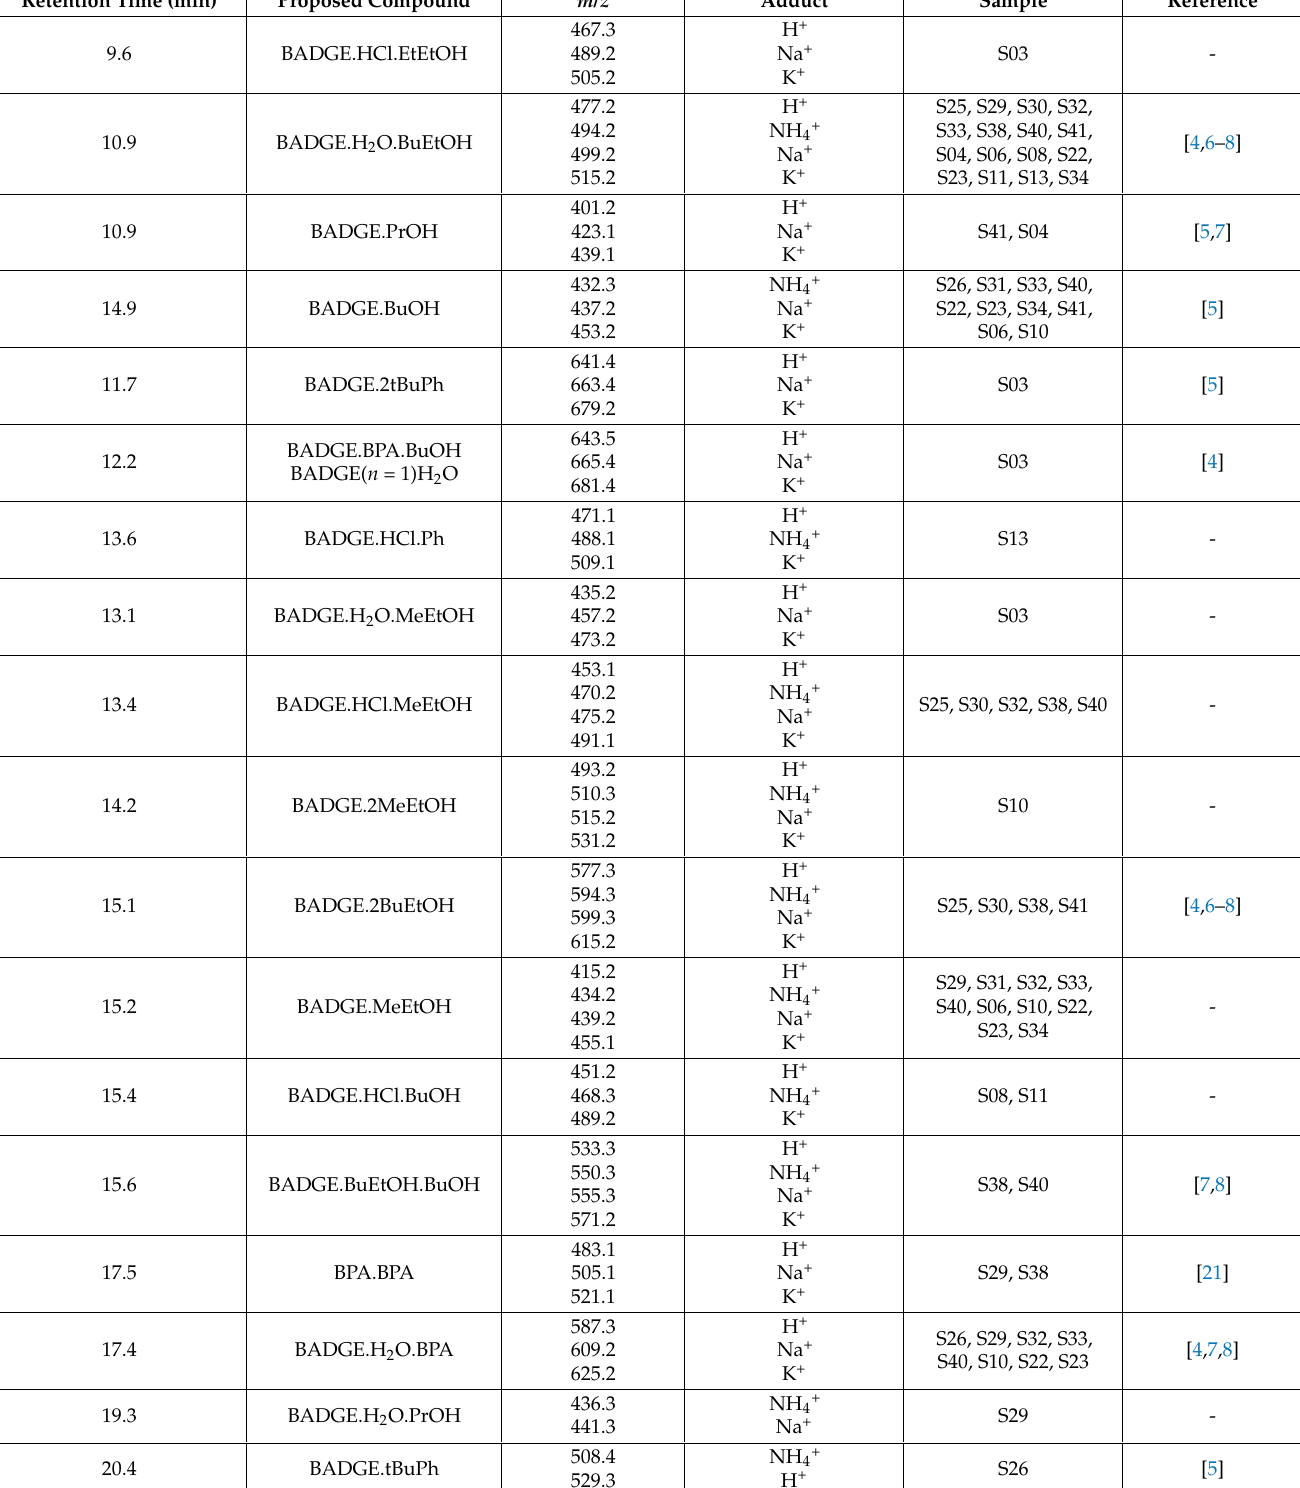
Table 4. Tentative identification of epoxy oligomers in the food